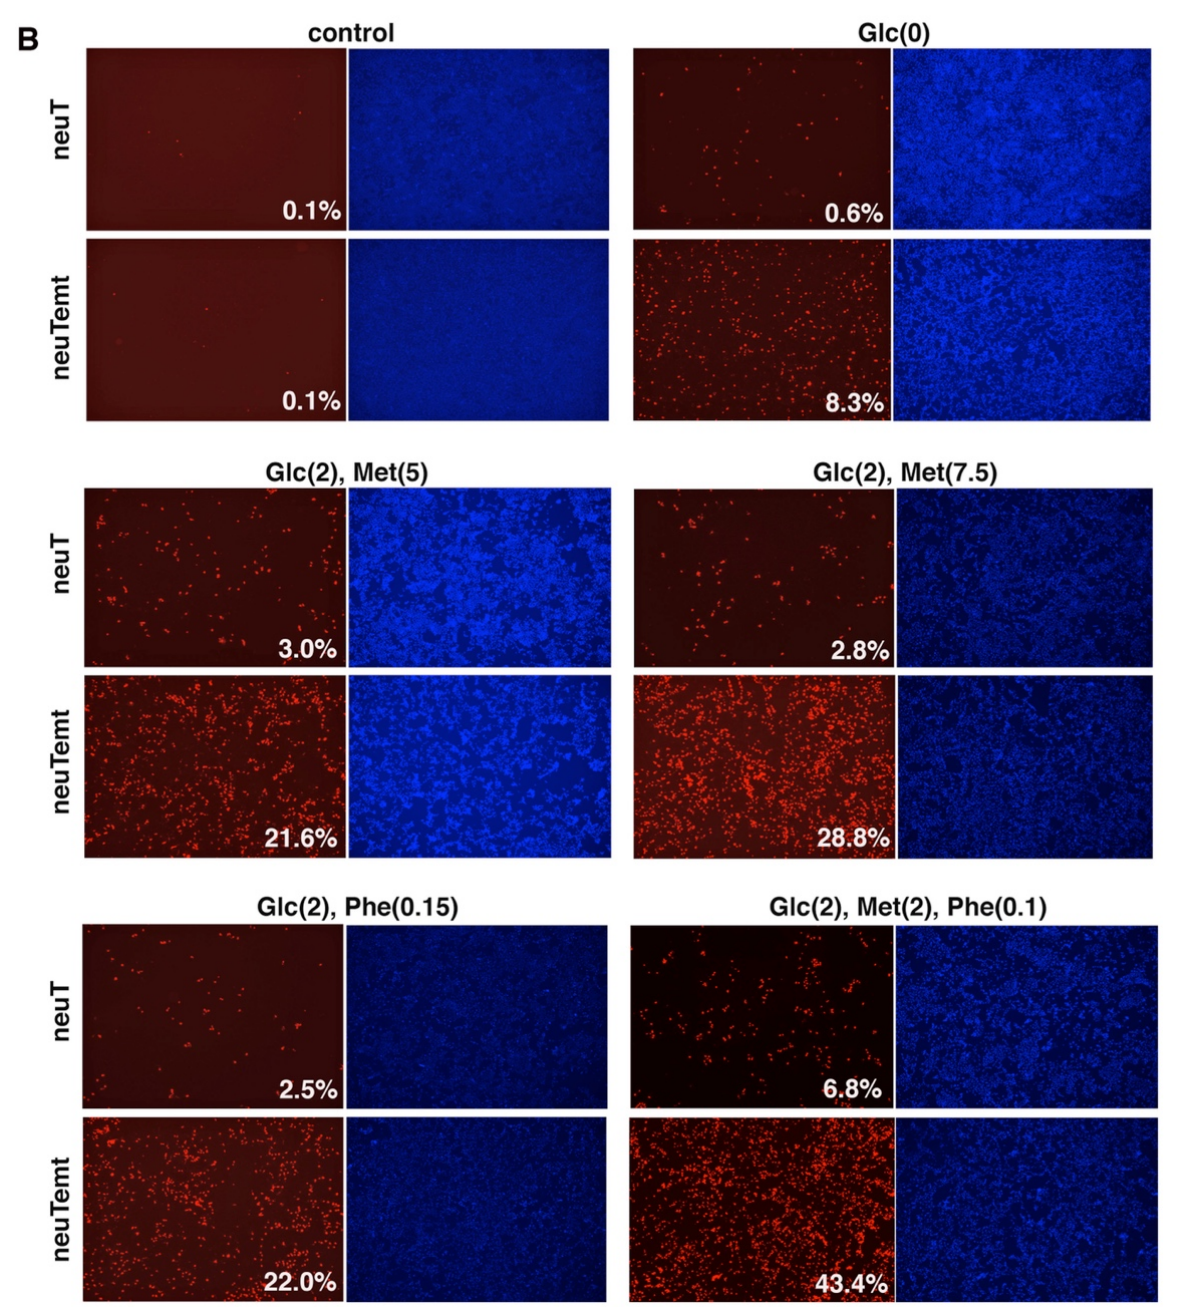
Figure 7. EMT cells are hypersensitive to various energy stress conditions. ( A ). NeuT and neuTemt cells were subjected to glucose deprivation or low glucose ± metformin or phenformin for 15 and 48 h. Cell viability was determined by trypan blue exclusion assay. ( B ). NeuT and neuTemt cells were subjected to indicated metabolic stress for 15 h, and stained with PI/HO. Percent dead cells (red/blue) was quantified with ImageJ. Numbers in parentheses are concentrations (in mM). Glc: glucose. Met: metformin. Phe: phenformin. Data shown as mean ± S.D. * p < 0.01.